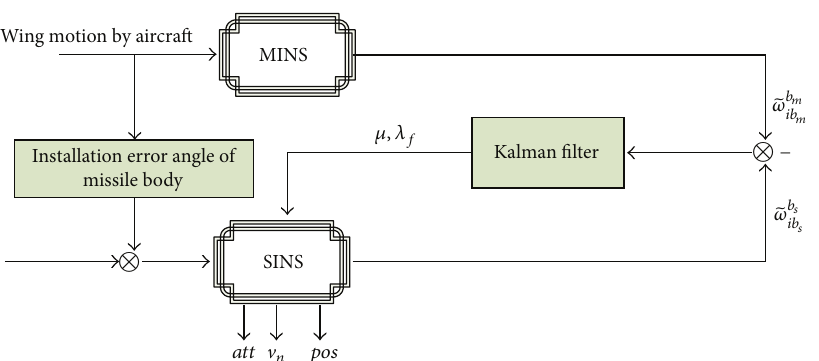
Figure 2: The principle diagram of angular rate